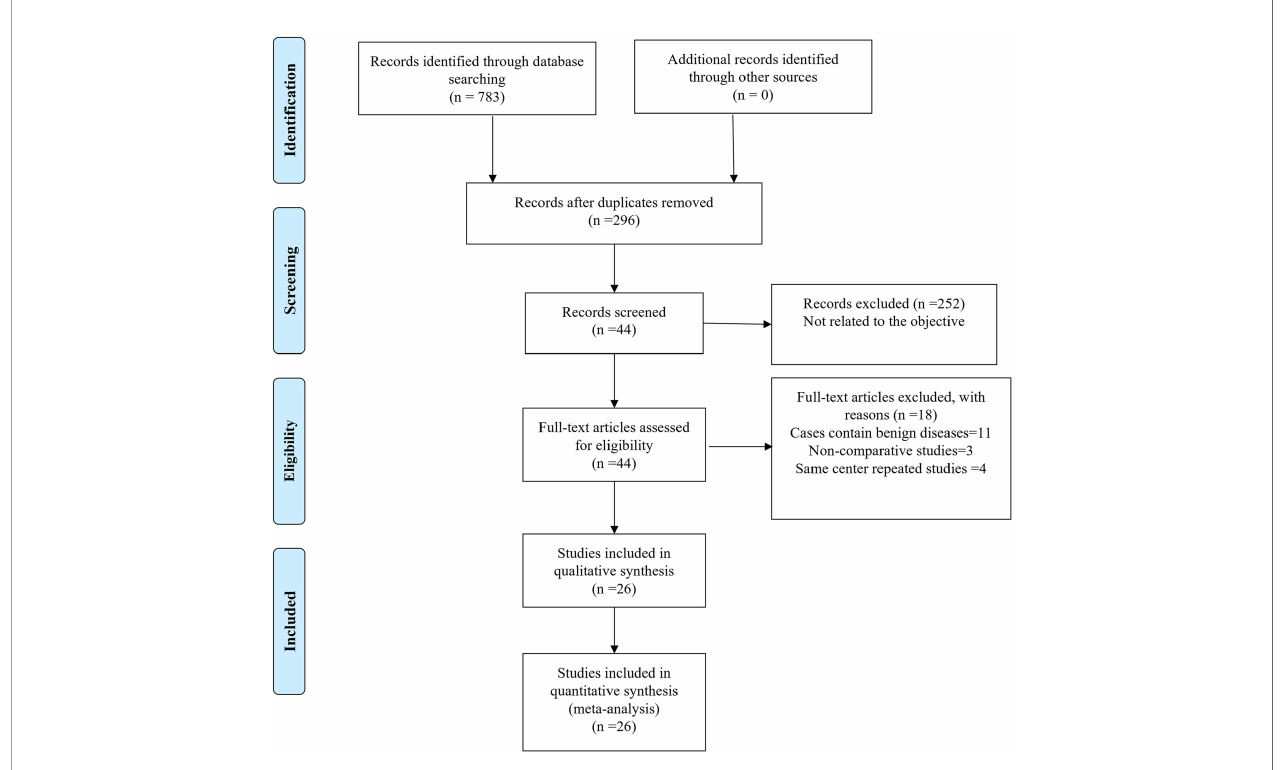
FIGURE 1 | Flowchart of study identi fi cation and